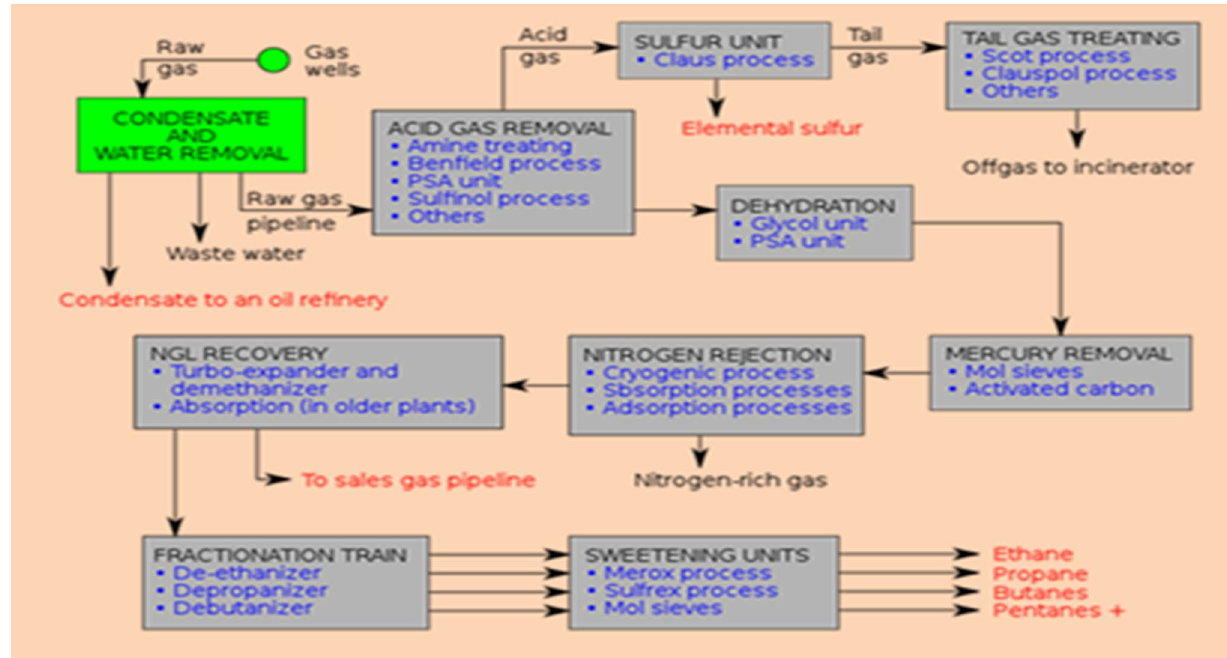
Fig. 1 Schematic diagram of a gas processing line